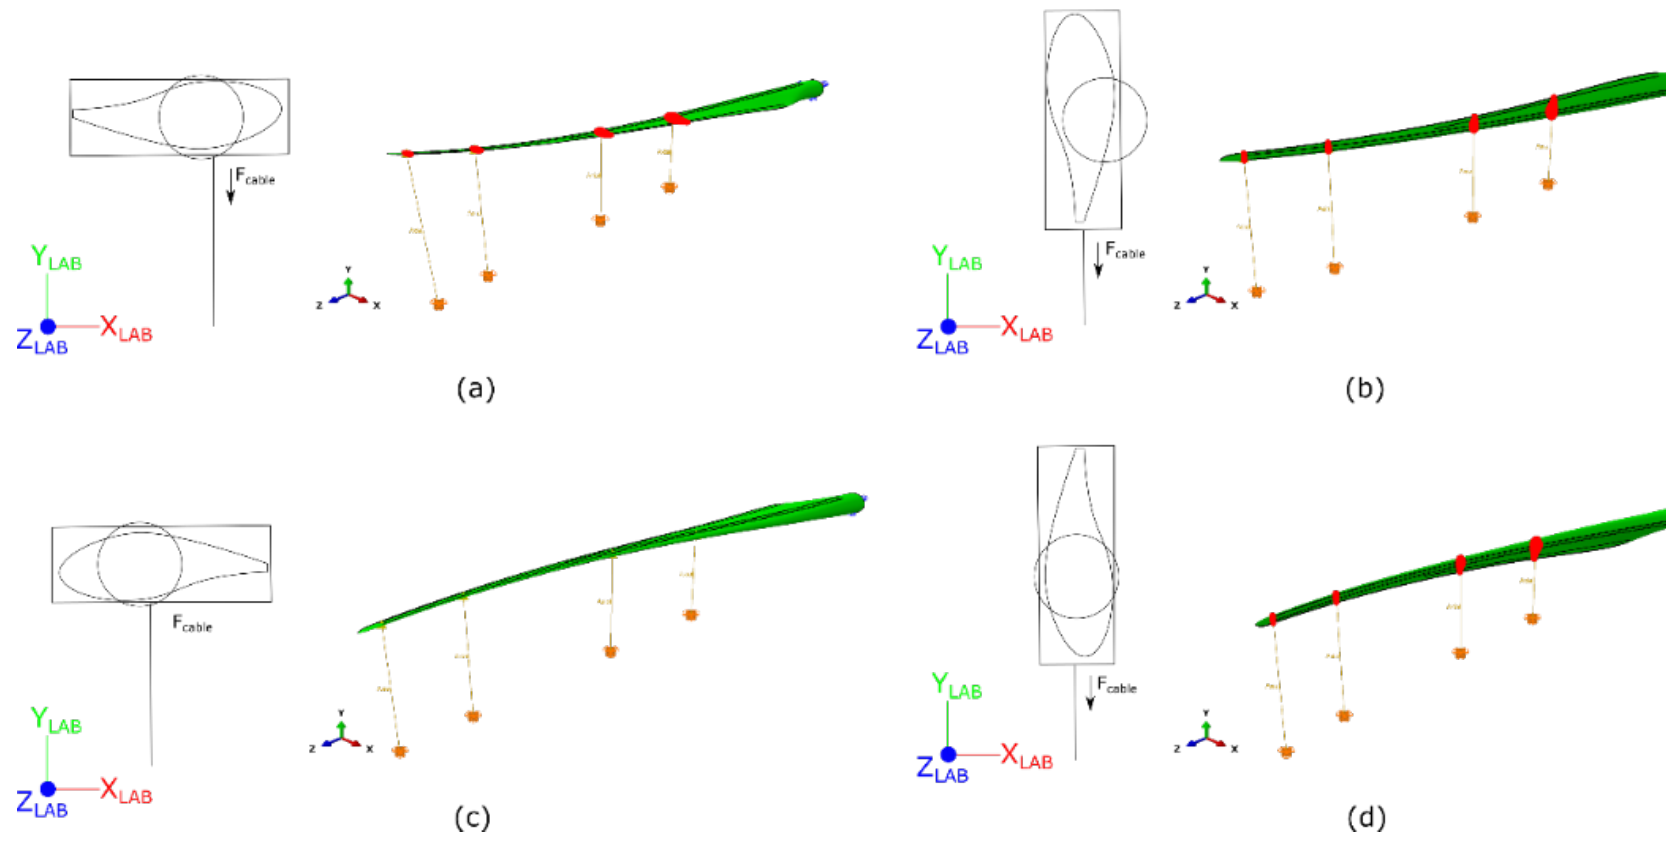
Figure 2. Schematic overview of the different load cases. The different loads were created by attaching the blade to the test stand at different pitch angles. ( a ) Blade positioned for the positive flatwise load case; ( b ) blade positioned for the positive edgewise load-case; ( c ) blade positioned for the negative flatwise load case; ( d ) blade positioned for the negative edgewise load case.